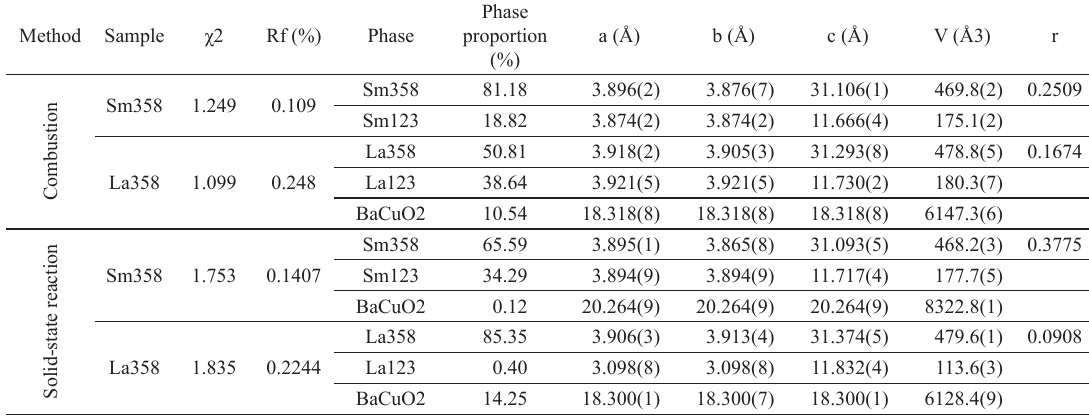
Table 1. Lattice parameters and calculated orthorhombicity ( r ) of the simples by each method. Method